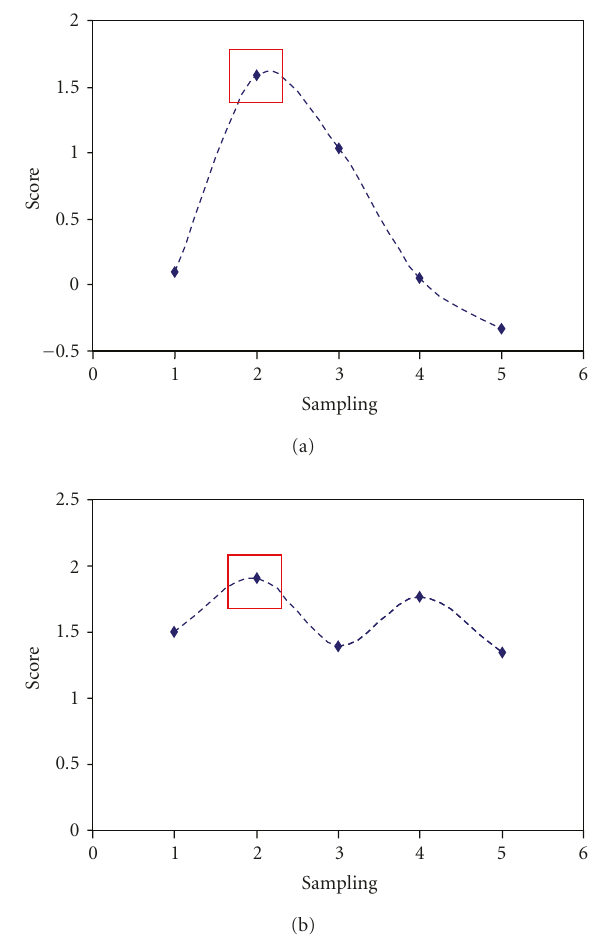
Figure 21: NA23A sequence, A S versus s n . (a) g = 0 case, Max Numbers = 3 and (b) g = 1 case, Max Numbers =